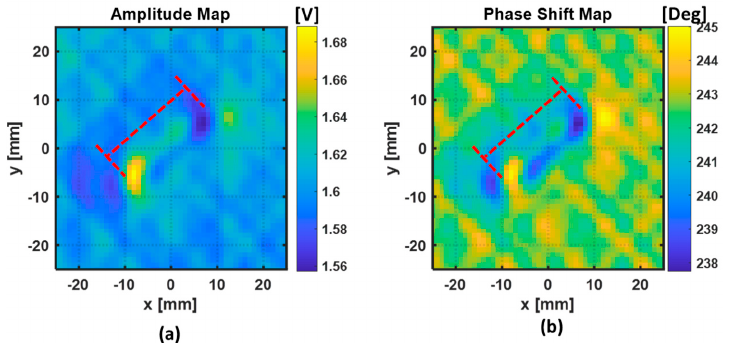
Figure 14. Representation of the C-scan performed in the vicinity of the estimated position of the fiber break, using ECT Configuration 2: ( a ) amplitude perturbations; ( b ) phase shift perturbations.